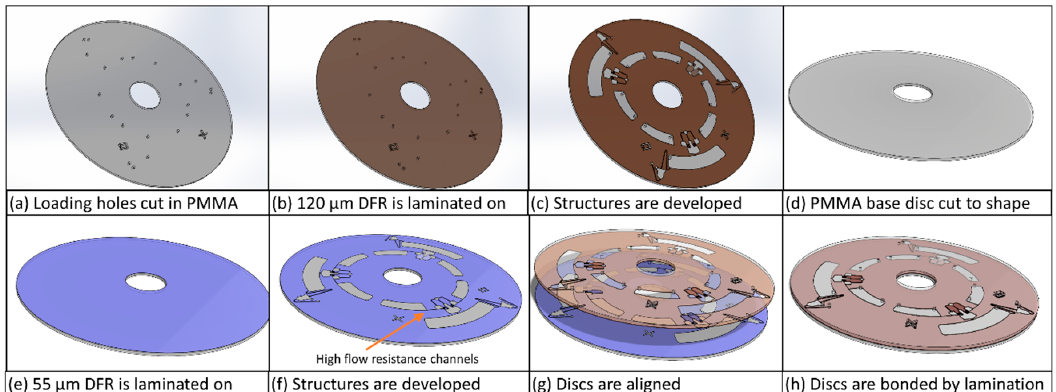
Figure 3. Schematic of the process for direct fabrication in dry film resist (DFR). 120 µm Dry Film Resist (DFR) (Ordyl P50120, Elga Europe, Milan, Italy) is represented by the red material and 55 µm DFR (SY 350, Elga Europe, Italy) by the blue material. The high flow resistance channels between the educt chambers and the discretization chambers are only present in the 55 µm DFR. DFR is applied, and the final assembly bonded, by hot-roll lamination. Structures are cured and developed according to the manufacturers’ protocols.